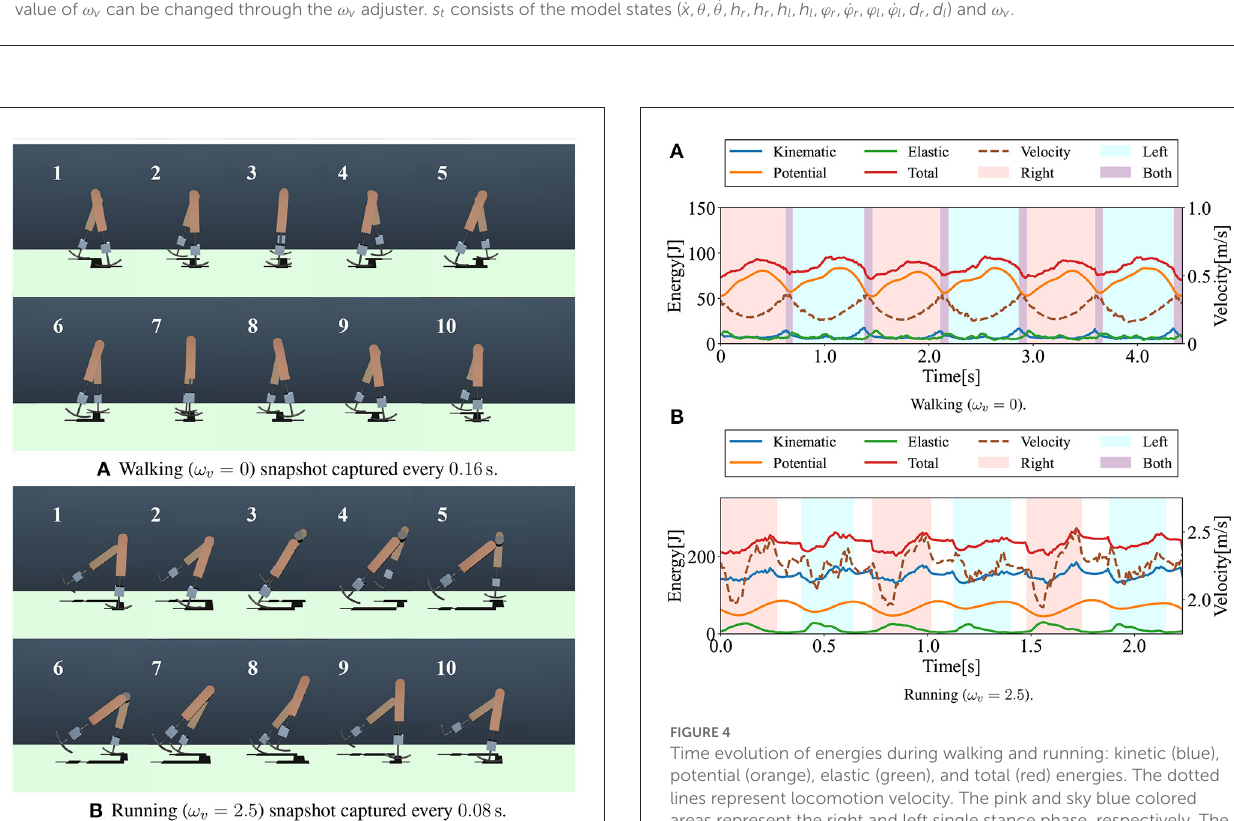
FIGURE3 Snapshots of the generated gaits. (A) Walking ( ω v captured every 0.16s. (B) Running ( ω v 0.08s.